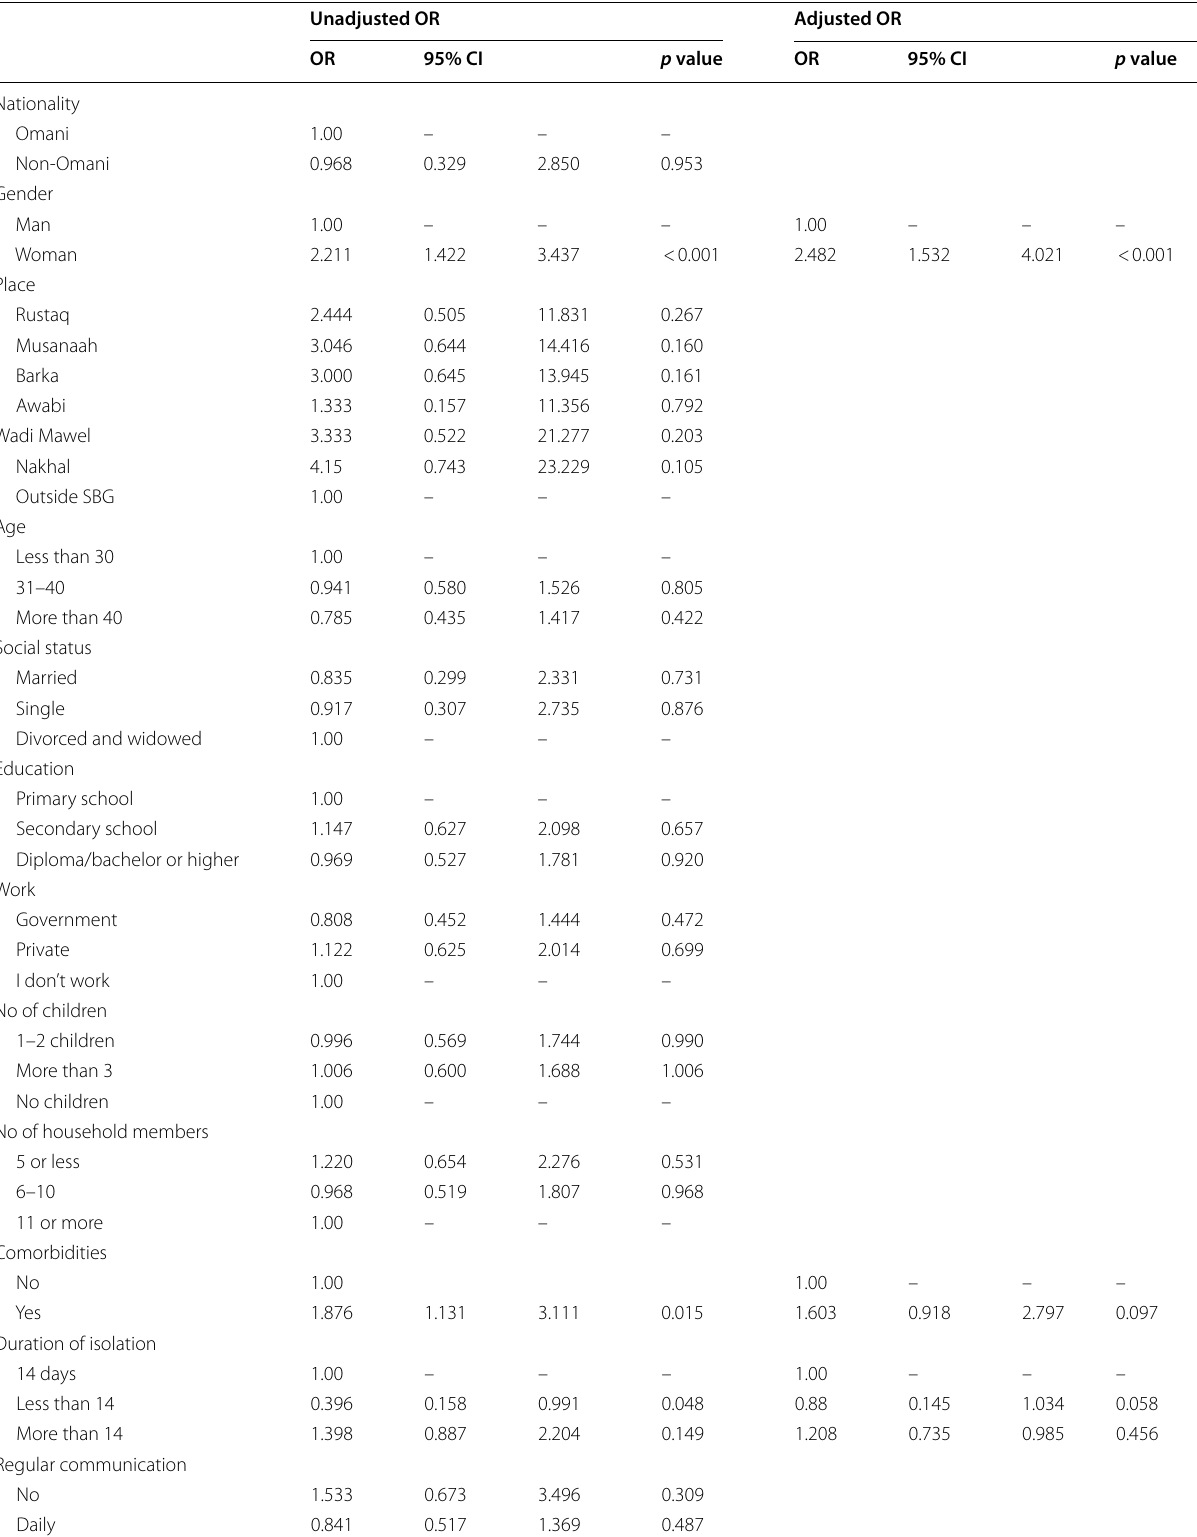
Table 4 The factors associated with high stress (Kessler score): binary logistic regression Unadjusted OR Adjusted